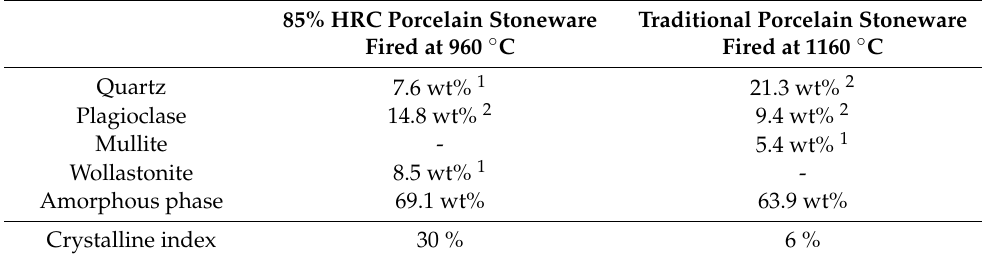
traditional porcelain stoneware materials sintered in the laboratory